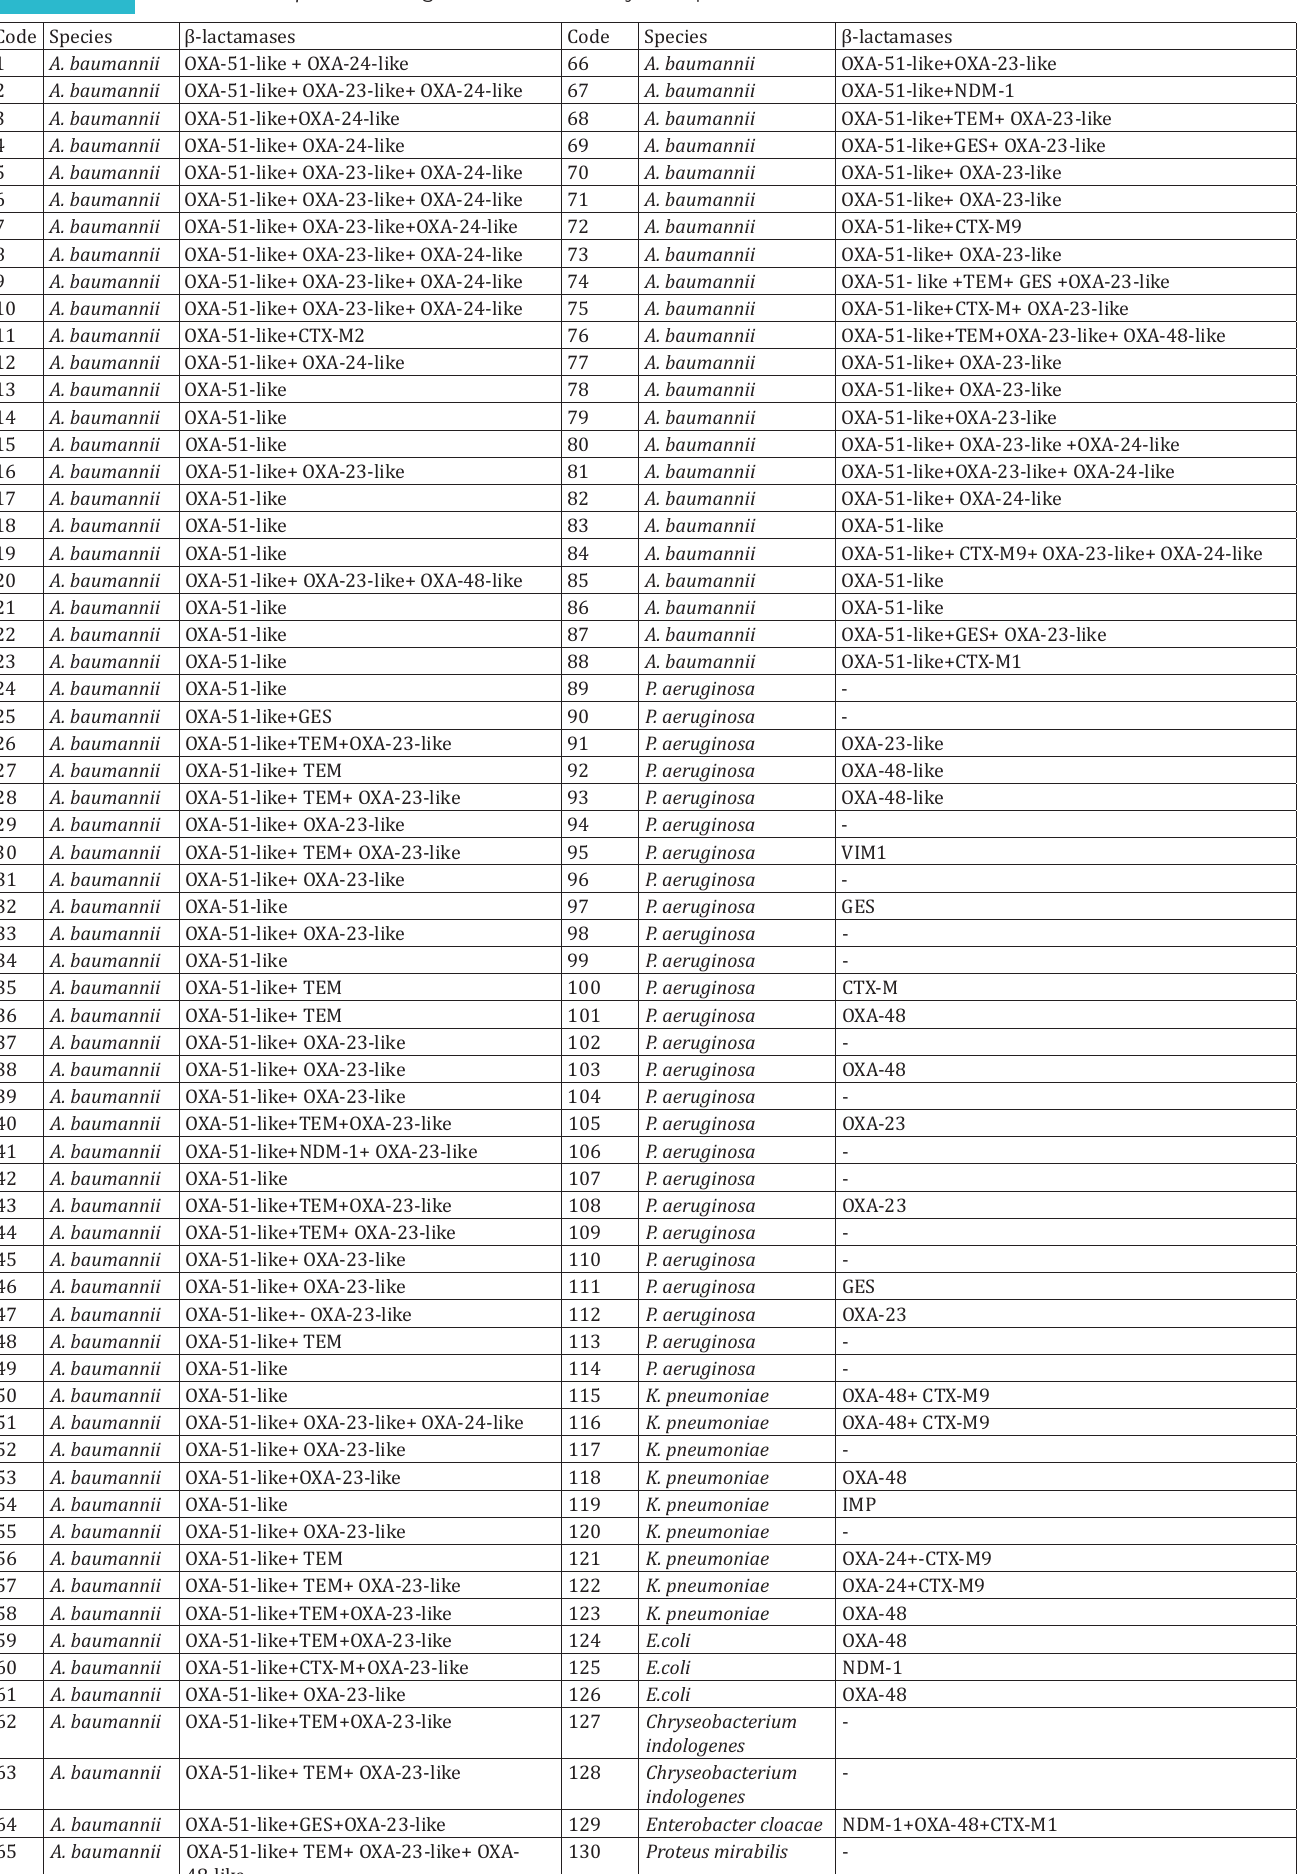
Table 11 Distribution of β -lactamase genes determined by multiplex-PCR in all isolates